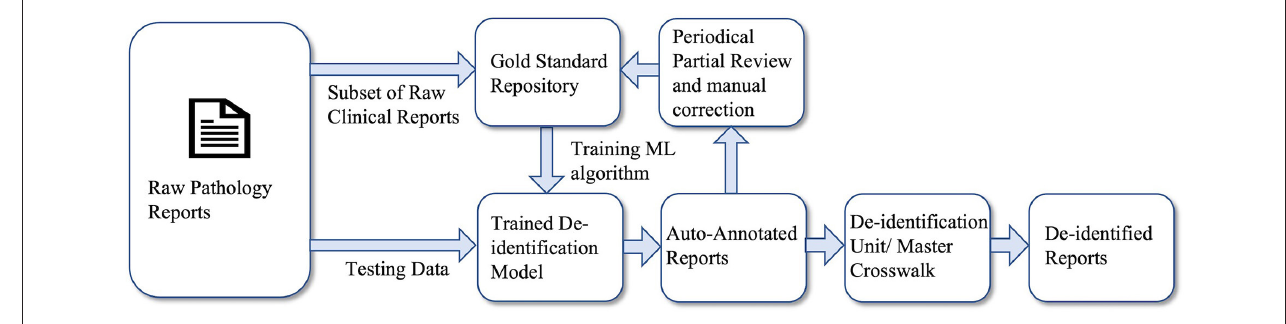
FIGURE 4 | Framework for automatic clinical de-identification